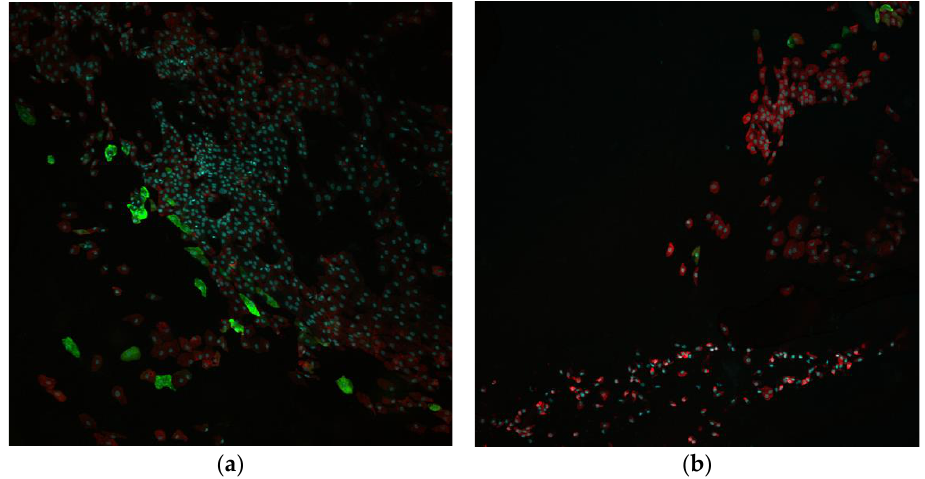
Figure 6. Impression cytology and immunofluorescent staining of the samples obtained from the LSCD-affected eye. ( a ) Central corneal sample. Nuclei are many, well stained with many K7 positive cells (red) with moderate expression (++), and a small number of K-12 positive cells (green) with strong expression (+++). ( b ) Corneal periphery sample. Nuclei are many, well stained; many K7 positive cells (red) with strong expression (+++), and few K12 positive cells (green) with strong expression (+++). Anti-K7 (OV-TL 12/30) (1:100, ab216016, mouse monoclonal, Abcam, UK); anti-K12 (1:100, ab185627, rabbit monoclonal, Abcam, UK). Confocal laser scanning microscopy, ethanol- fixed samples, immunocytochemistry, and immunofluorescence: green — Alexa Fluor ® 488 (1:250, ab150077, goat anti-rabbit, Abcam), red — Alexa Fluor ® 594 (1:250, ab150116, goat anti-mouse, Abcam), blue — Hoechst 33342 (ab228551, Abcam).